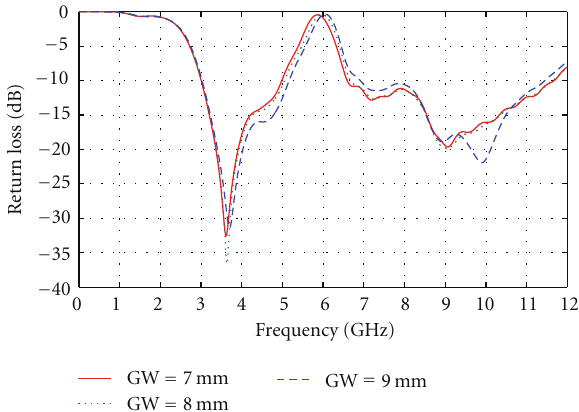
Figure 5: Simulated return losses due to parameter GW.